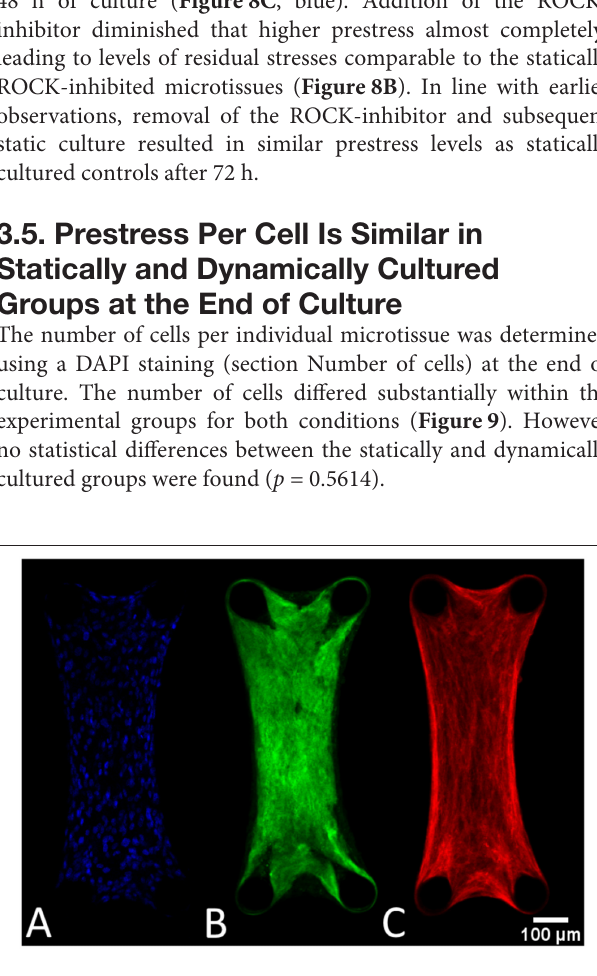
FIGURE 9 | Boxplot of the number of cells per microtissue for the statically (Left) and dynamically (Right) cultured groups at the end of the experiment.